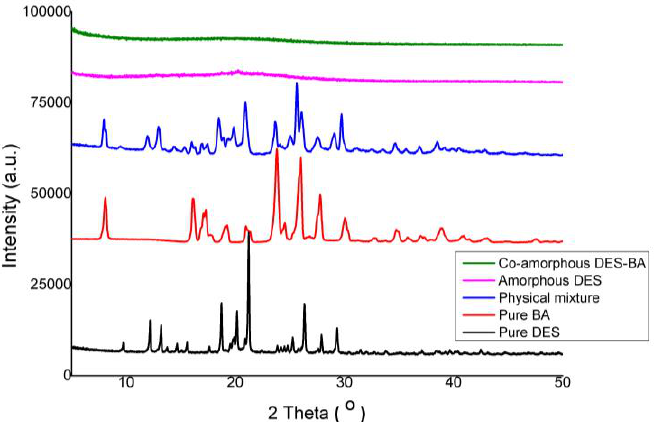
Figure 1. PXRD patterns of pure desloratadine (DES) (black line), pure benzoic acid (BA) (red line), physical mixture (blue line), pure amorphous DES (pink line), and co-amorphous DES–BA (green line).